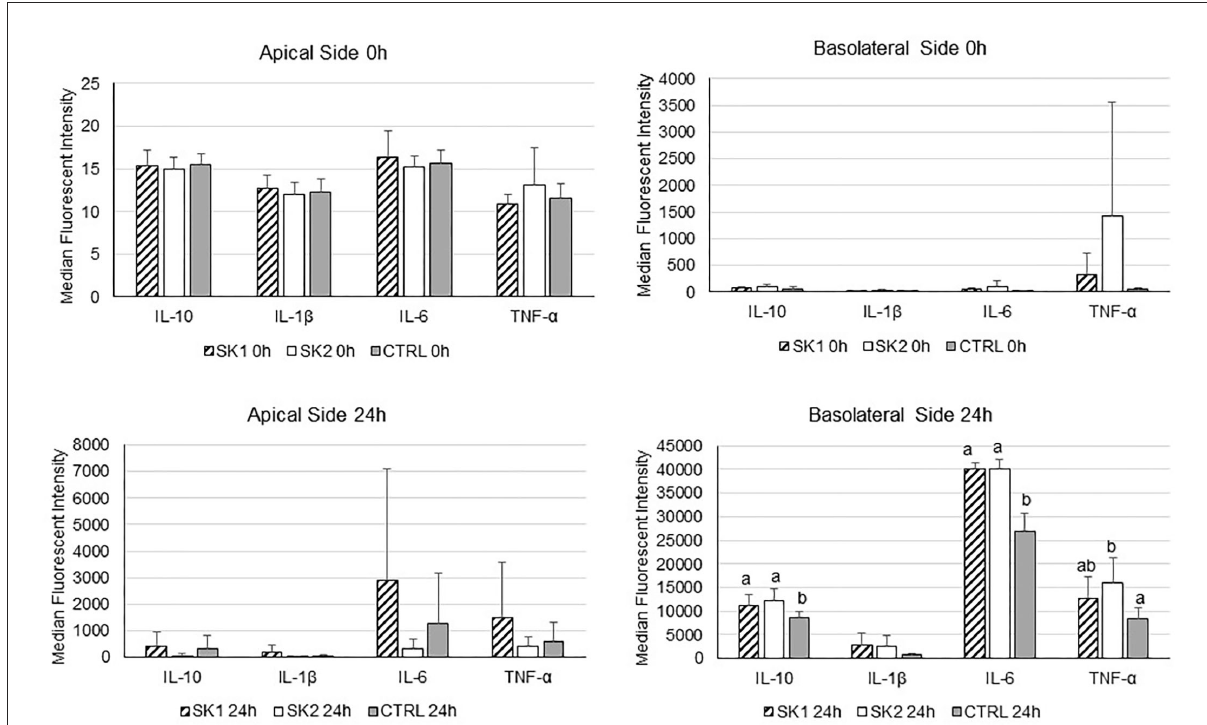
FIGURE6 IL-10, IL-1 β , IL-6, and TNF- α secretion by co-cultured Caco-2 (apical side) and PBMCs (basolateral side) under LPS stimulation at baseline (0h) and after 24h of incubation with sauerkraut brine (SK1 and SK2) or control cell culture medium (CTRL). Bar plots represent median values of median fluorescent intensity (MFI) of the Magpix ® signal, and the error bars represent standard deviation ( n = 3). Note the different scales on the y-axis. Different superscript letters indicate statistically significant differences within each